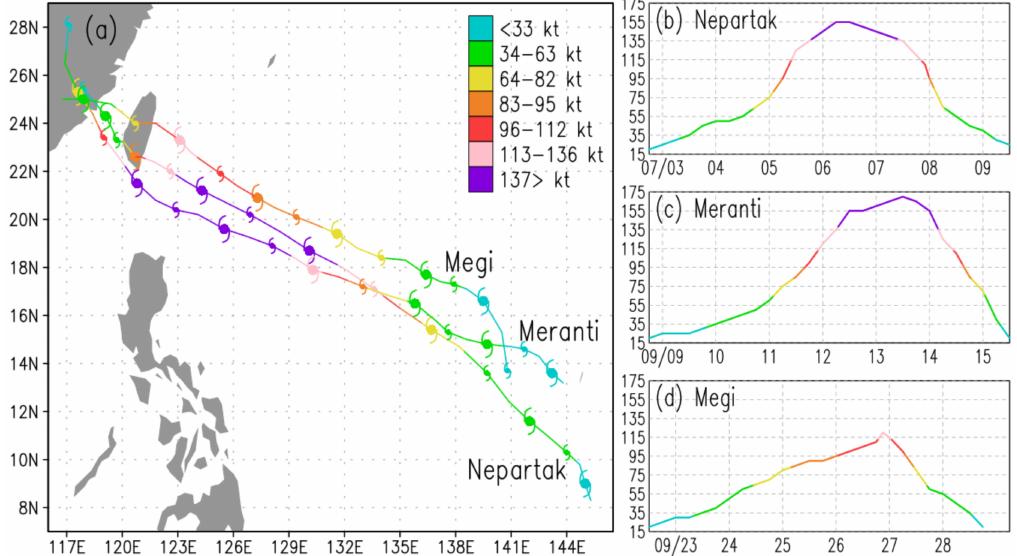
Figure 1. ( a ) TC tracks for Nepartak, Meranti, and Megi. Symbols are plotted with 12-hourly. TC Intensities for ( b ) Nepartak, ( c ) Meranti, and ( d ) Megi. Each line color indicates storm intensity categories on the Sa ffi r-Simpson